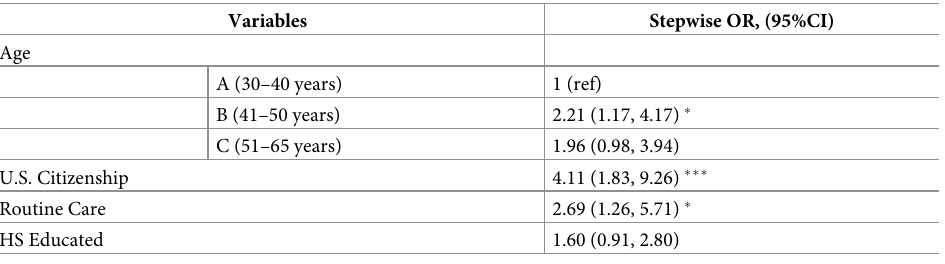
Table 4. Stepwise regression model ( n = 333).